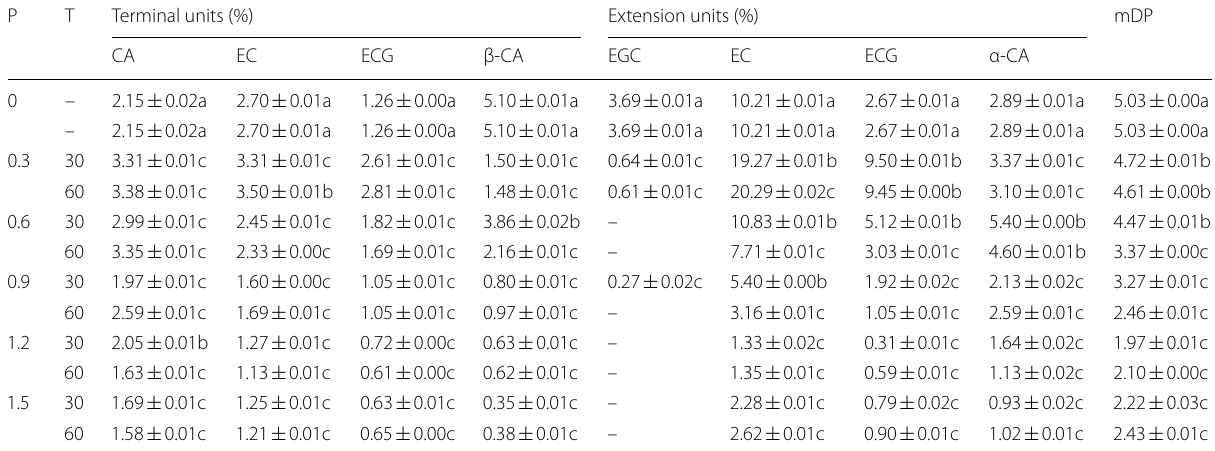
standard deviation ( n 3). Means in the same column with ± =